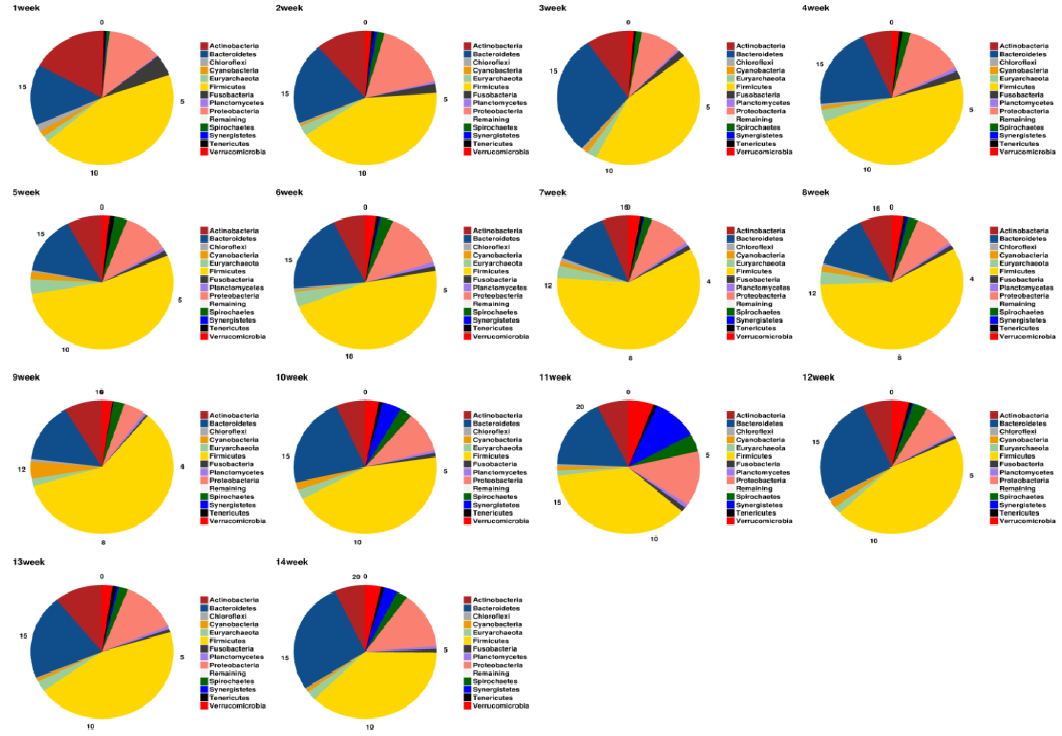
Figure 4. Taxonomic annotation of the polled sample from the three slurry pits, the abundance of Firmicutes , Bacteroidetes, etc., can be observed throughout the storage duration (first to 14th week). Each color represents the relative abundance (%) for each phylum.